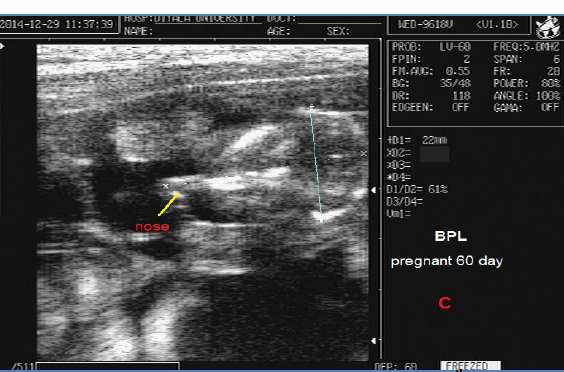
Figure, 7: Measurement of fetal BPD in 9 th week of pregnancy, indicated by straight line (Linear probe,